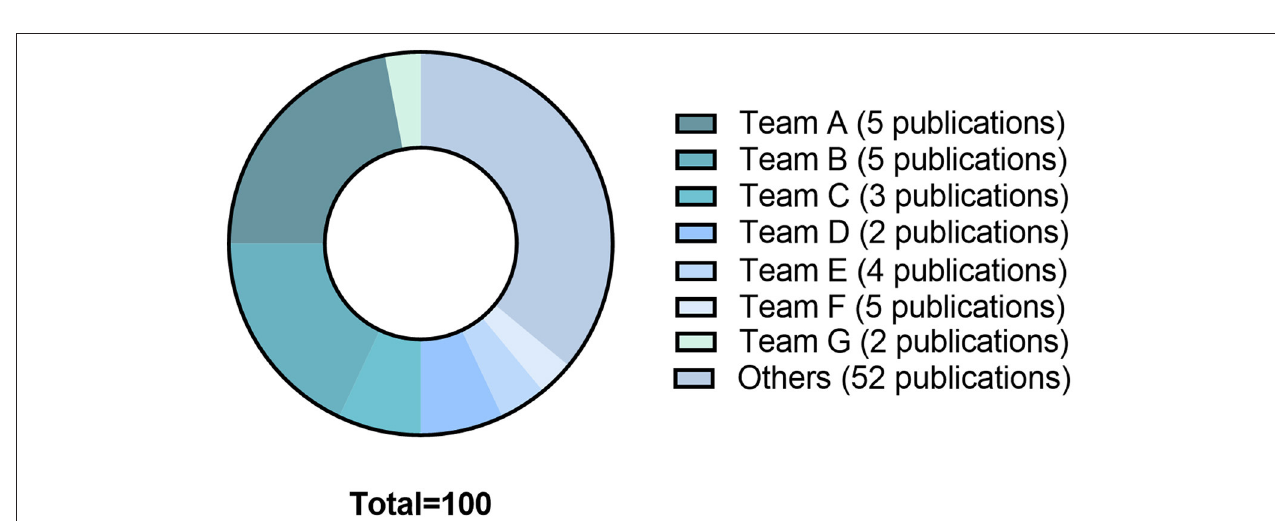
FIGURE 2 | PRISMA flow diagram of the systematic review; 78 studies were included in our systematical review.